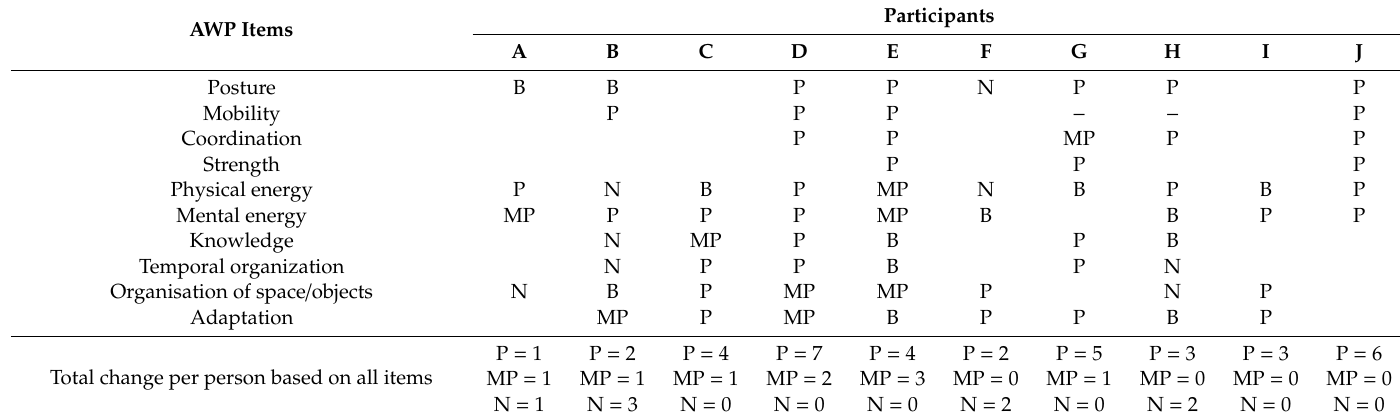
Table 4. Participants´ changes on assessment in work performance between baseline and after three months of work trial, assessed with the Assessment of Work Performance